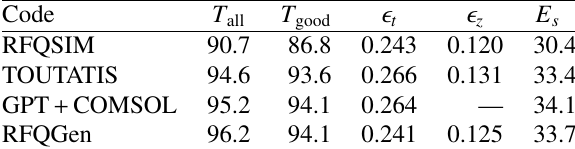
Figure 7. Electric field in the surface of vane tips around a gap between segments. The shape of the end of the vanes is elliptical. Table 2. Simulation results at the output of the RFQ for the four methods used. The figures of merit are: full transmission (%), accelerated transmission (%), transverse normalized rms emittance ( π mmmrad) calculated as the average between the horizontal and the vertical values, longitudinal rms emittance ( π de g MeV) and maximum surface electric field (MV / m).